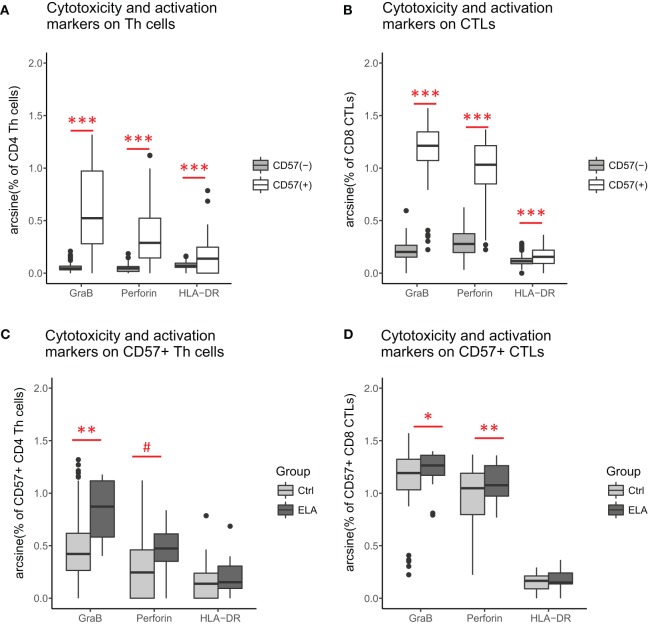
Cytolytic potential and activation status: CD57+ versus CD57− Th cells (A) and CTLs (B). ELA versus controls among CD57+ Th cells (C) and CTLs (D). Statistics: Paired Wilcoxon rank sum test with continuity correction (A,B), linear regression with group and experimental day as fixed effects, and percentage of cells as outcome variable (C,D). p-Values are corrected for multiplicity with false discovery rate. #p < 0.10, *p < 0.05, **p < 0.01, ***p < 0.001. Abbreviations: Ctrl, control; ELA, early life adversity; GraB, granzyme B; HLA-DR, human leukocyte antigen–antigen D related; CTL, cytotoxic T lymphocyte; Th cell, T helper cell.